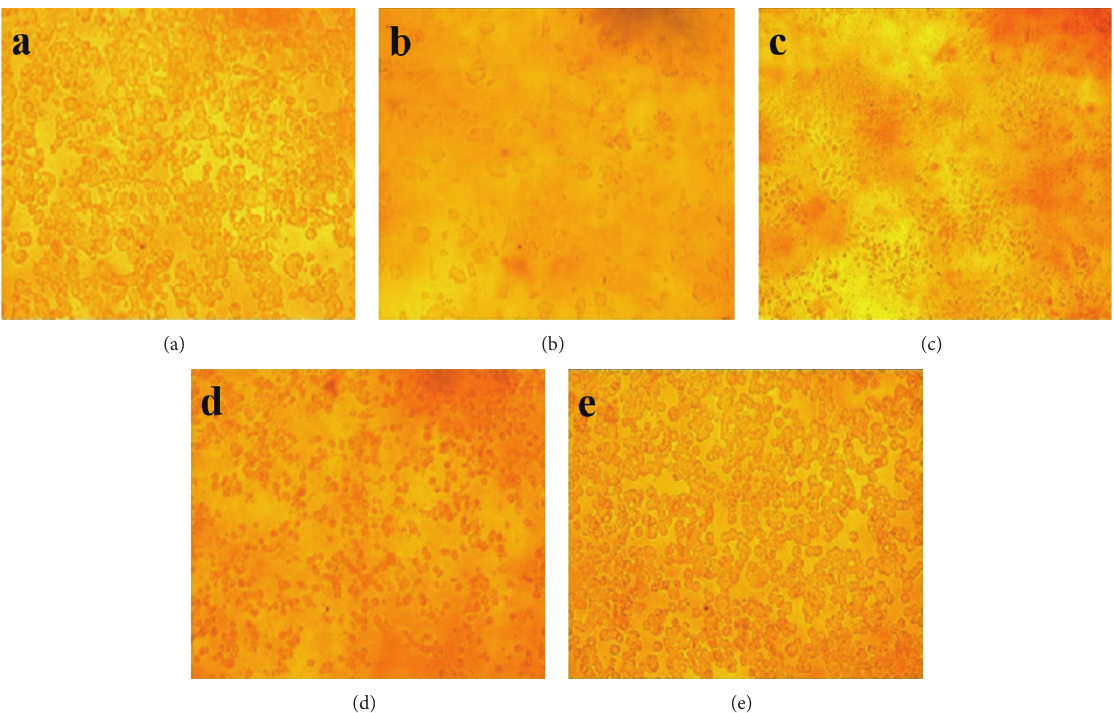
Figure 7: Cytotoxic anticancer evaluation of polymer on MCF-7 cell line at different concentrations: (a) normal MCF-7 cell line, (b) 1000 𝜇 g/mL (c) 125 𝜇 g/mL (d) 62.5 𝜇 g/mL (IC 50 ), and (e) 31.2 𝜇 g/mL.